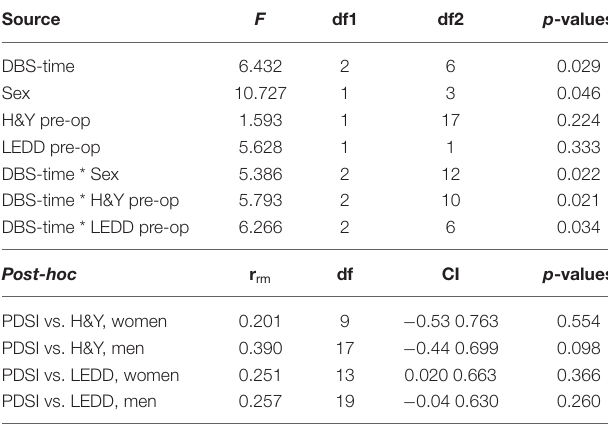
The reported values for the fixed effects are F-values, degrees of freedom (df1 and df2), and p-values. The reported values for the post-hoc repeated measures correlations are